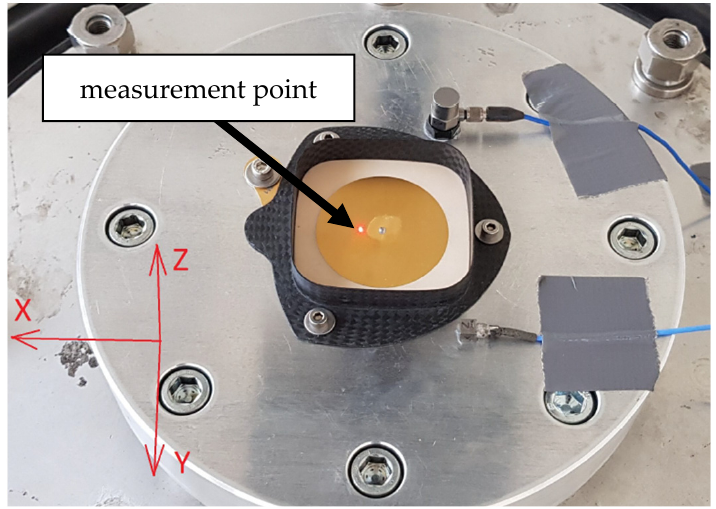
Figure 9. Satellite antenna panel mounted on the vibration machine with laser vibrometer measure- ment point.